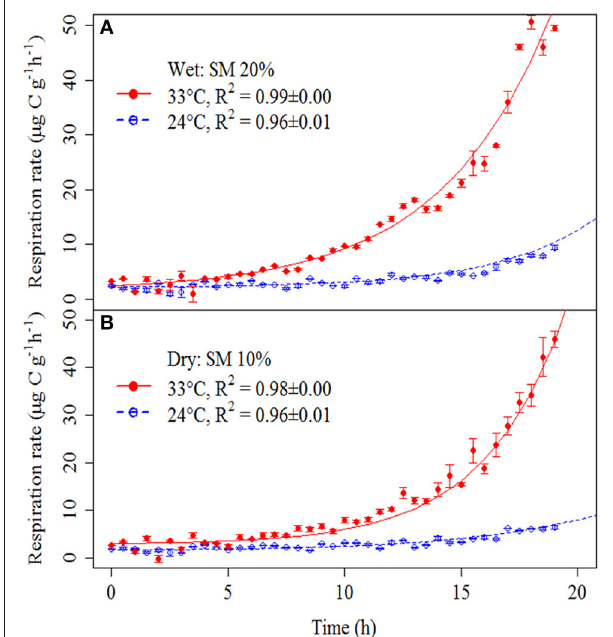
FIGURE 2 | Soil respiration rates after addition of a glucose and nutrient solution in wet (A) and dry (B) soils at different temperatures (heated soils, red solid circles/solid line; and unheated soils, open blue circles/dashed line). Symbols represent means ± SE. Lines were obtained by fitting the model parameters to measured soil respiration rates (see Materials and Methods Section). Fitted parameters are in Supplementary Table 2. Fitted lines are based on mean parameters values for each treatment. R 2 -values were calculated based on linearized model (Supplementary Figure 1) but exponential curves are shown to illustrate the exponential nature of the SIGR.